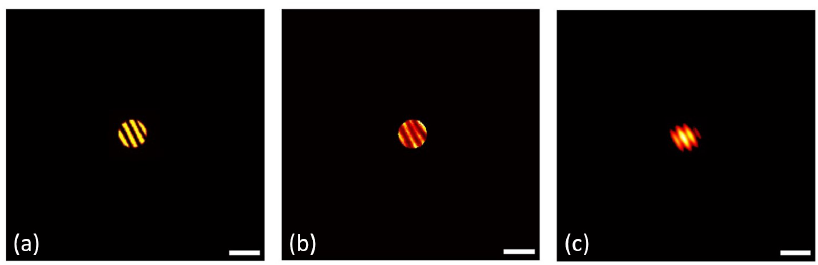
Figure 4. A comparison between the PIE and Fienup algorithm. ( a ) Target image and the reconstructed image ( b ) using our method, and ( c ) the traditional HIO phase retrieval algorithm. Scale bar: 1 mm.